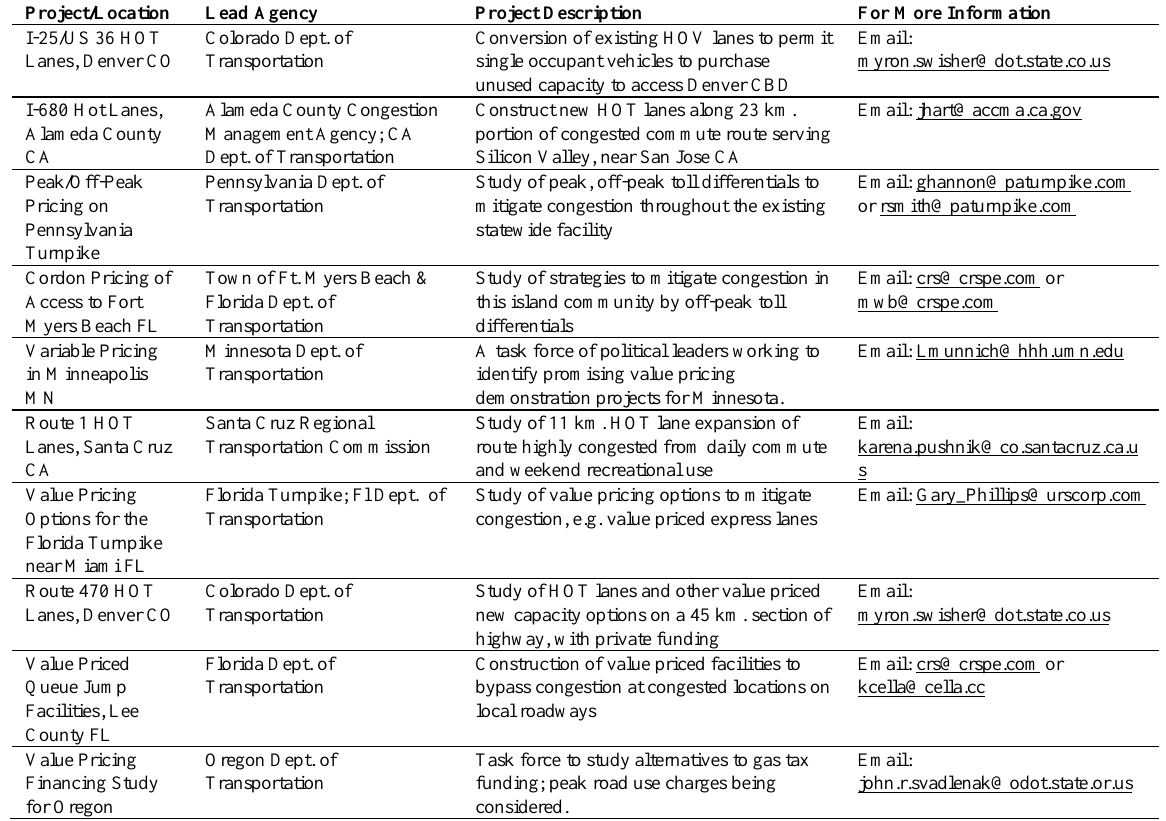
Table 3. Value Pricing Projects/Initiatives under